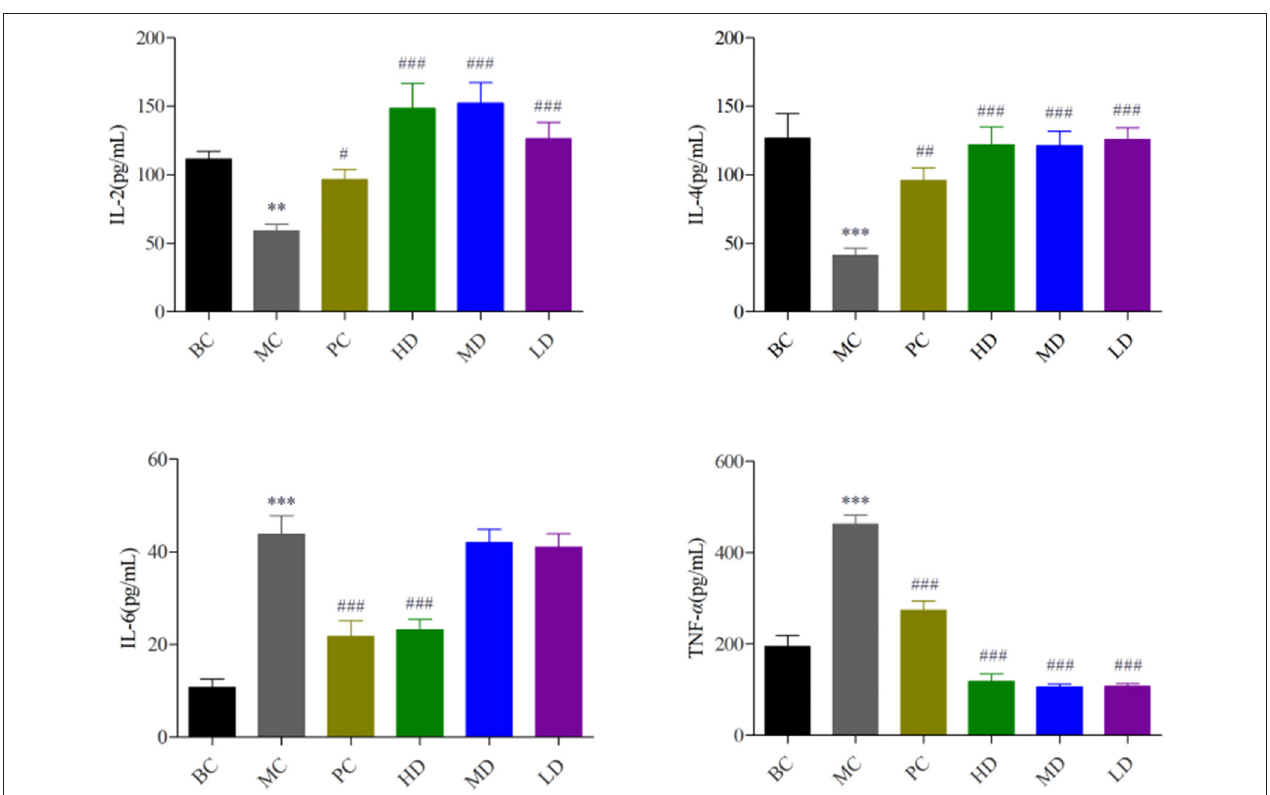
FIGURE 1 | Effect of F. velutipes polysaccharide on serum cytokine content. Compared with BC group: *** P < 0.001, ** P < 0.01; Compared with MC group: ### P < 0.001, ## P < 0.01, # P <